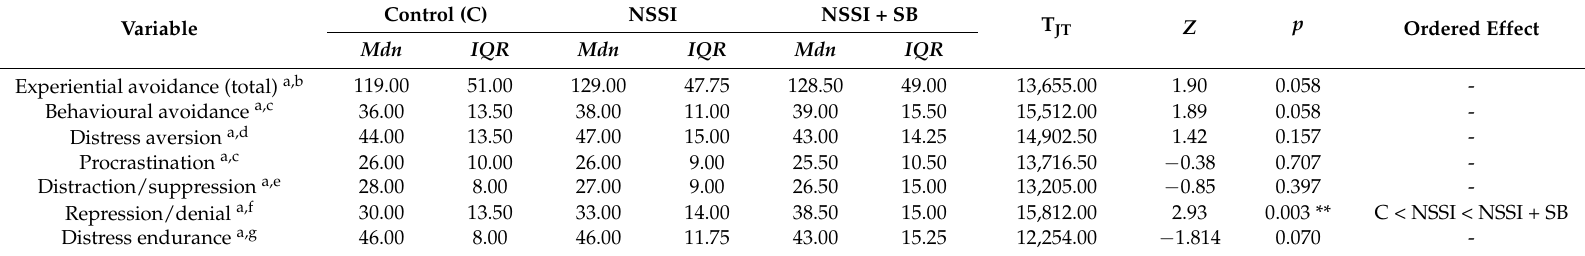
Table 2. Descriptive statistics and Jonckheere–Terpstra trend tests comparing experiential avoidance between Control, NSSI and NSSI + SB